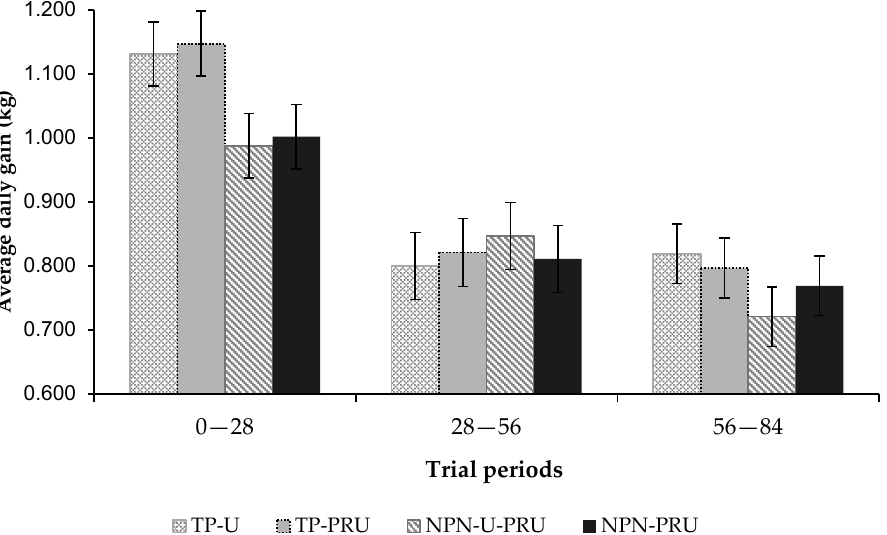
Figure 3. Average daily gain in kg per day, according to the experimental periods. 1° (First)—0 to 28; 2° (Second)—28 to 56; 3° (Third)—56 to 84.